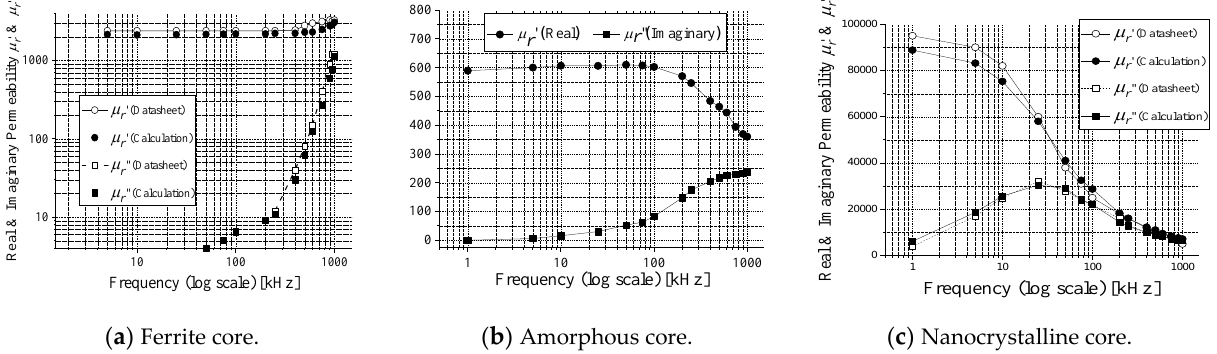
( a ) Ferrite core. ( b ) Amorphous core. ( c ) Nanocrystalline core. Figure 5. Calculated and LCR measurement results of the inductance for three different core materials.